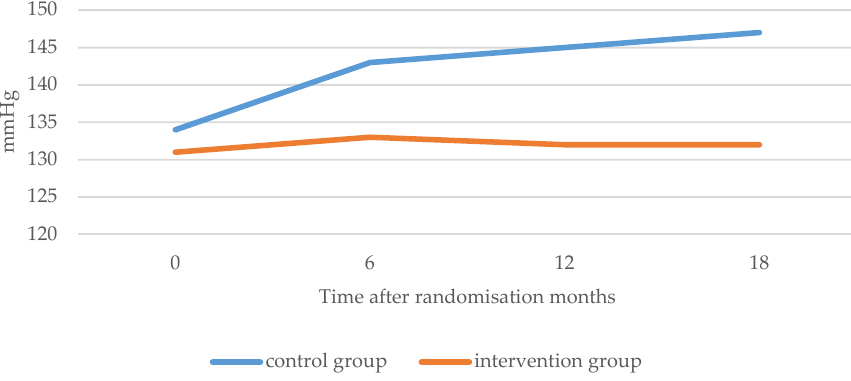
Figure 4. Evolution of systolic blood pressure in the two groups in the RCT study. Table 3. Evolution of the psychological outcomes in the RCT control group (CG) and intervention group (IG) during the 18-months Psychological outcomes: Table 3 shows the evolution of the trial results regarding psychological outcomes. At month 0, patients who indicated clinical signs and symptoms compatible with major depression (PHQ-9 cut-off criteria) were 28% of the population, 34% with minor depression, and 38% had no symptoms of depression.